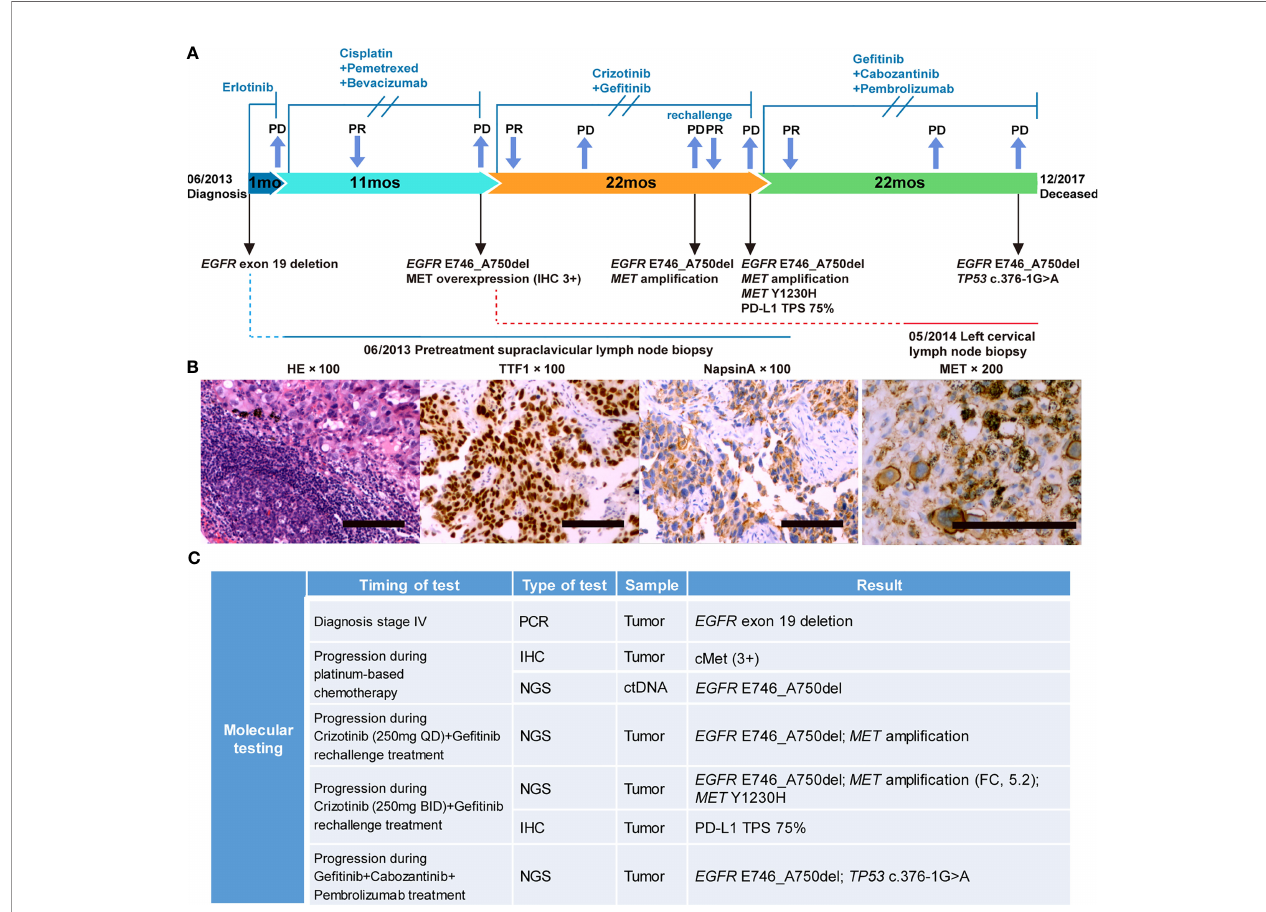
FIGURE 1 | Case summary. (A) Summary of disease course, treatment timeline, and key molecular fi ndings. (B) Hematoxylin-eosin staining, TTF1 and NapsinA positive immunohistochemical (IHC) staining before treatment; MET positive immunohistochemical staining during progression after platinum-based chemotherapy. Scale bars: 100 µm. (C) Detailed molecular alterations of tissue and liquid biopsy. FC, fold change; TPS, tumor proportion